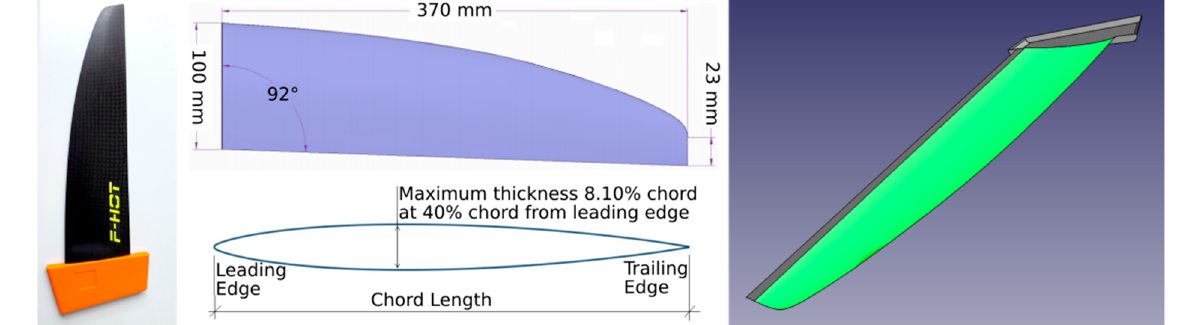
Figure 1. Slalom fin (and mould) geometry.